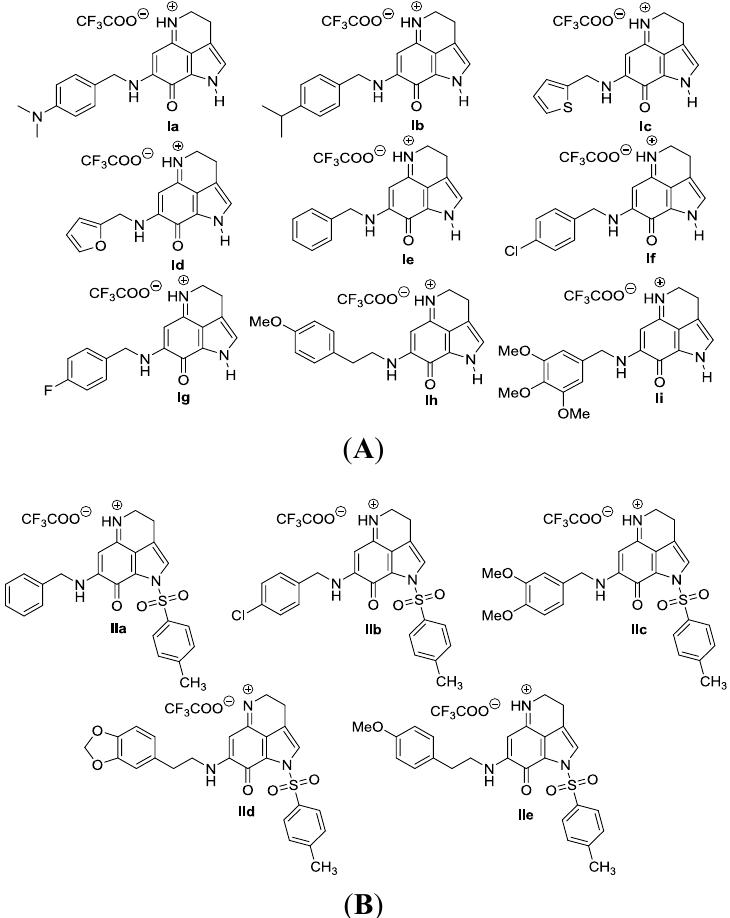
Figure 2. ( A ) Makaluvamine analogs with free pyrrole NH (Class I); ( B ) makaluvamine analogs with a tosyl group on pyrrole N (Class